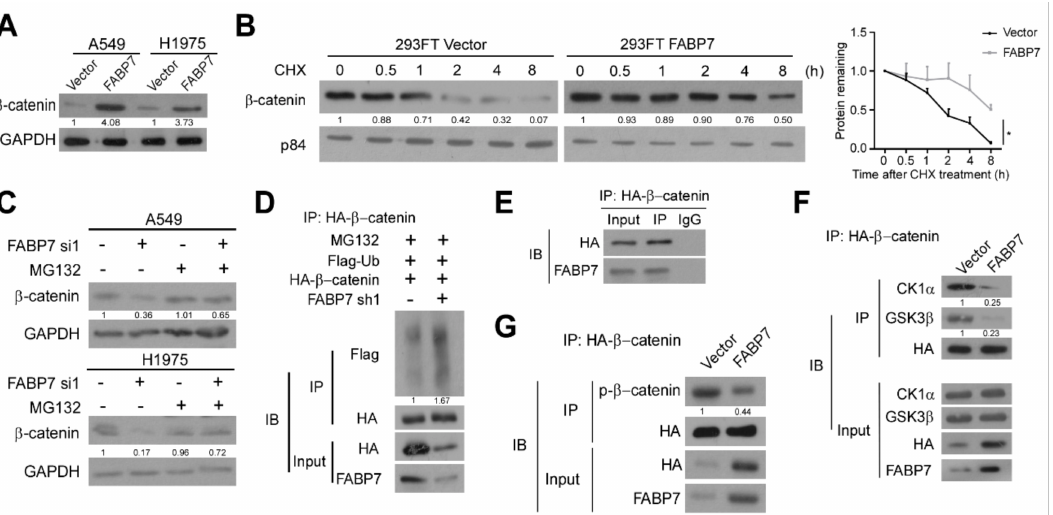
Figure 5. FABP7 stabilizes β -catenin by inhibiting its ubiquitin-proteasomal degradation. ( A ) Western blotting analyses on β -catenin levels in indicated NSCLC cells stably expressing vector or FABP7. ( B ) Western blotting analyses (left) and corresponding quantitation (right) on β -catenin stability in 293FT cells with indicated treatments in the presence of CHX. Error bars represent the means ± SD derived from three independent experiments, and statistical analyses were performed by two-sided Mann-Whitney test (*: p < 0.05). ( C ) Alteration of β -catenin stability after indicated treatments in the presence of MG132 with or without FABP7 depletion by Western blotting analyses. ( D ) Co- immunoprecipitation (co-IP) assays in stable FABP7 knockdown A549 cells show changes of β -catenin polyubiquitination in the presence of MG132. ( E ) Interaction between FABP7 and purified β -catenin protein in A549 cells. ( F ) Interaction between β -catenin and destruction complex components upon FABP7 overexpression in A549 cells. ( G ) Co-IP assays show changes in β -catenin phosphorylation by FABP7 overexpression in A549 cells. Representative images are from three independent